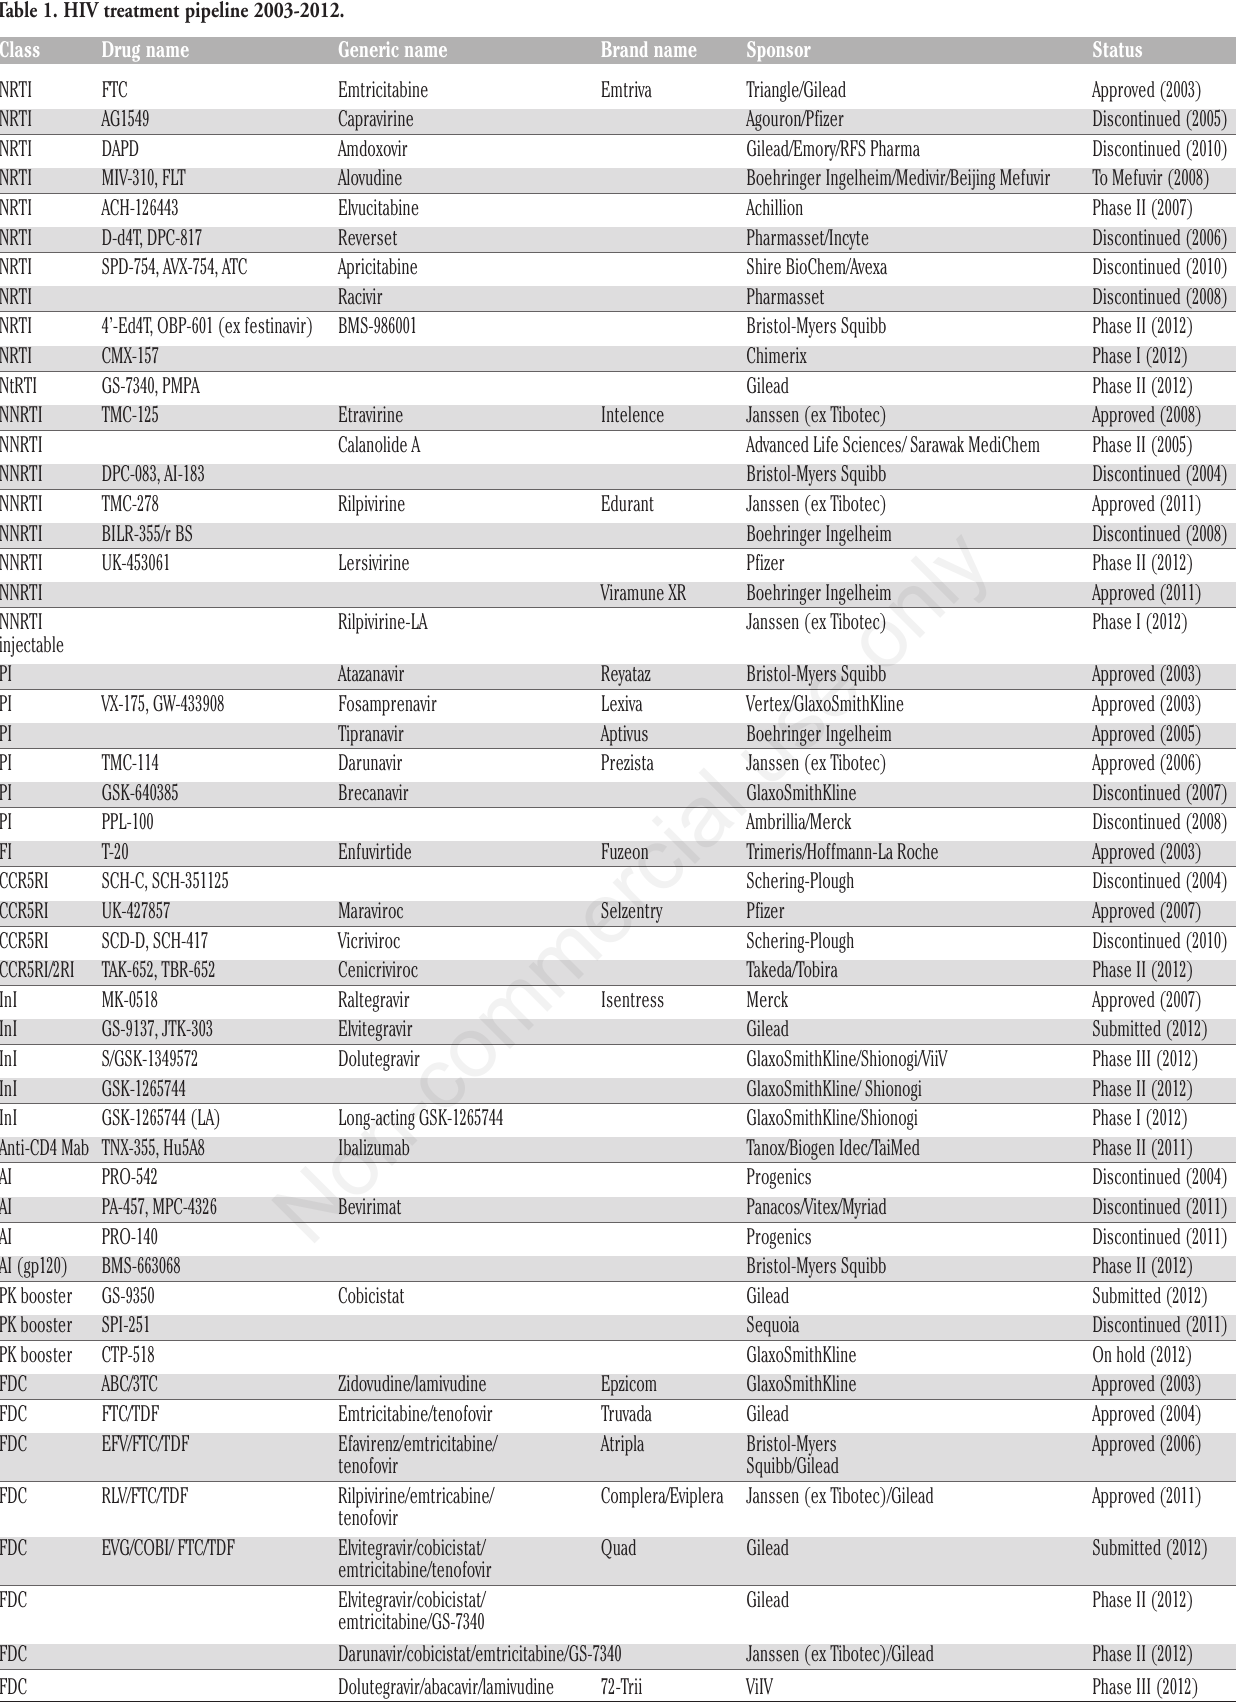
Table 1. HIV treatment pipeline